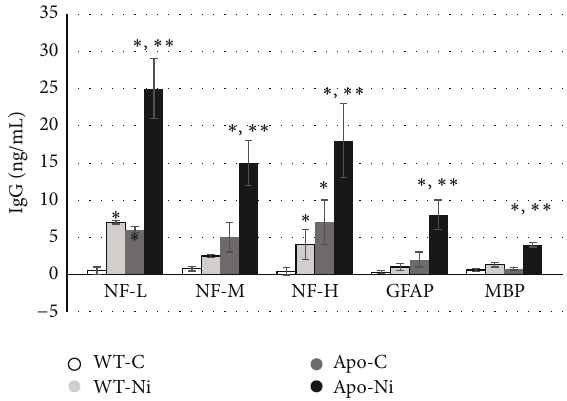
Figure 7: Inhalation exposure of wild-type C57BL/6 (WT) and ApoE knock out male mice to arc-spark generated Ni-NP ( ≤ 40nm; 5 h/wk for 6wks) resulted in detectable levels of IgG against neurotypic (NF) and gliotypic (GFAP and MBP) proteins. Levels of IgG were significantly ( 𝑃 < 0.05 ) higher in ApoE −/− mice exposed to Ni-NP compared to WT controls, WT exposed to Ni-NP ( ∗ ) or ApoE −/− control mice ( ∗∗ ) (inhalation exposures conducted by L. C. Chen and P. Gillespie at New York University Institute of Environmental